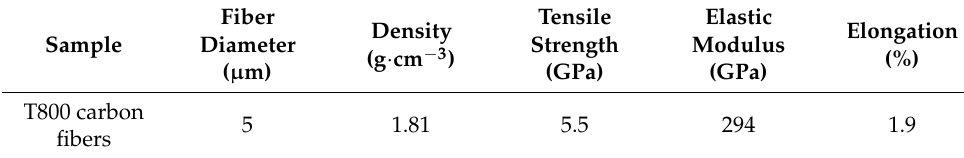
Table 1. Properties of T800 carbon fibers.